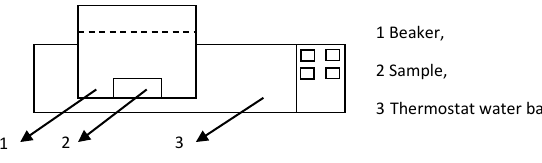
Figure 3. Schematic diagram of the leaching apparatus.